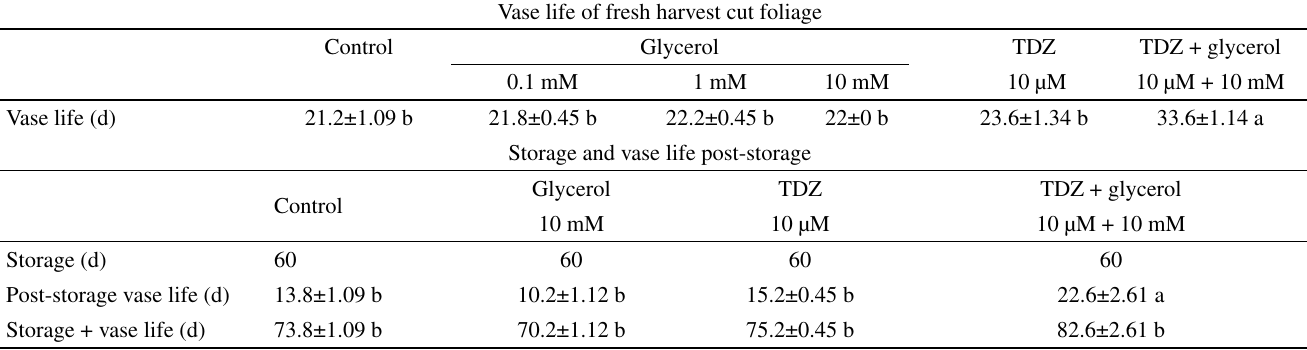
Table 2 - Vase life before and after storage of cut foliage treated with glycerol (0.1, 1 or 10 mM), 10 µM TDZ or a combination 10 µM TDZ plus